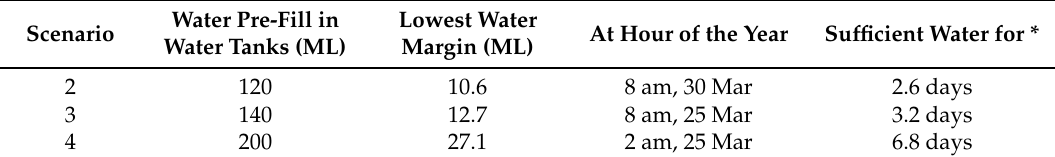
Table 4. Safety margin for water storage